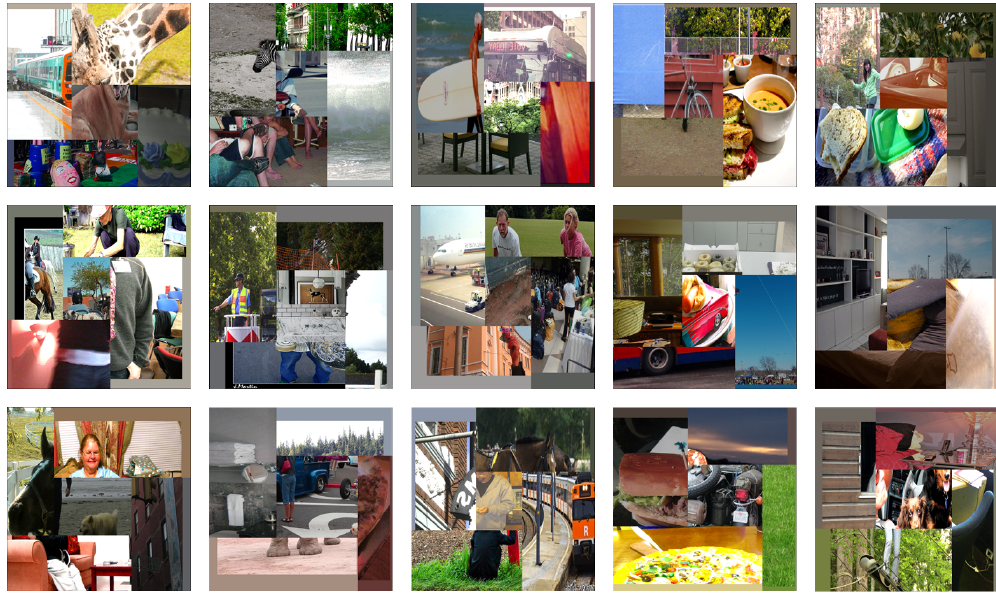
Figure 7. The examples of Admix, we mix information from five images at once to implement data